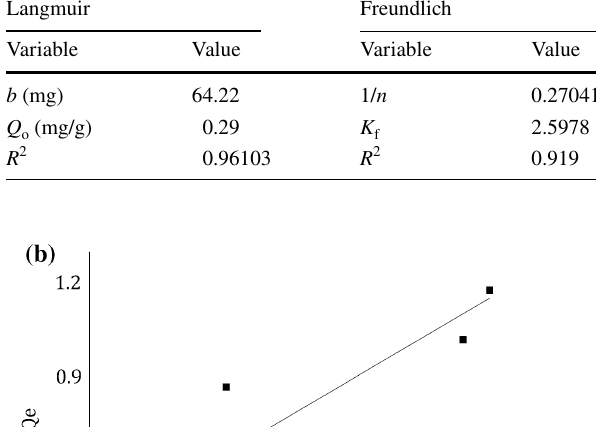
Table 8 Isotherm model constants and correlation coefficients